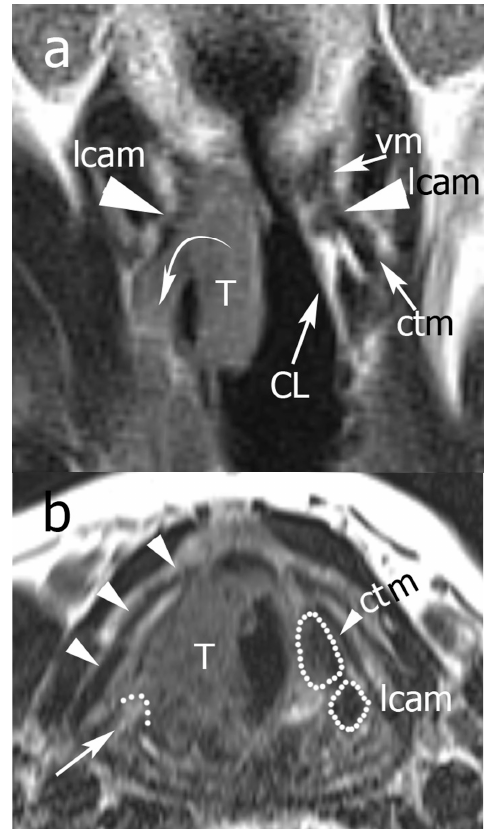
Figure 5. Example of Pattern C. From top to bottom: ( a ) TSE-T2 on coronal plane; ( b ) TSE-T2 on axial plane. In ( a ) the right glottic-subglottic tumor infiltrates the inferior PGS (curved arrow) extending outside the larynx, the vocal and lateral cricoarytenoid muscles are partially infiltrated, and the cricoarytenoid muscle is completely undetectable because of invasion (the same muscles are normally visible on the left side). There is infiltration of the right cricoid lamina, although it is normal on the left side. In ( b ) the tumor infiltrates the lateral cricoarytenoid and cricothyroid muscles, visible on the left side. Arrowheads indicate the right thyroid lamina, which is not infiltrated. A curved dotted line and arrow indicate the posterior front of the neoplasm. Legend: CL, cricoid lamina; ctm, cricothyroid muscle; lcam, lateral cricoarytenoid muscle; T, tumor; vm, vocal muscle.